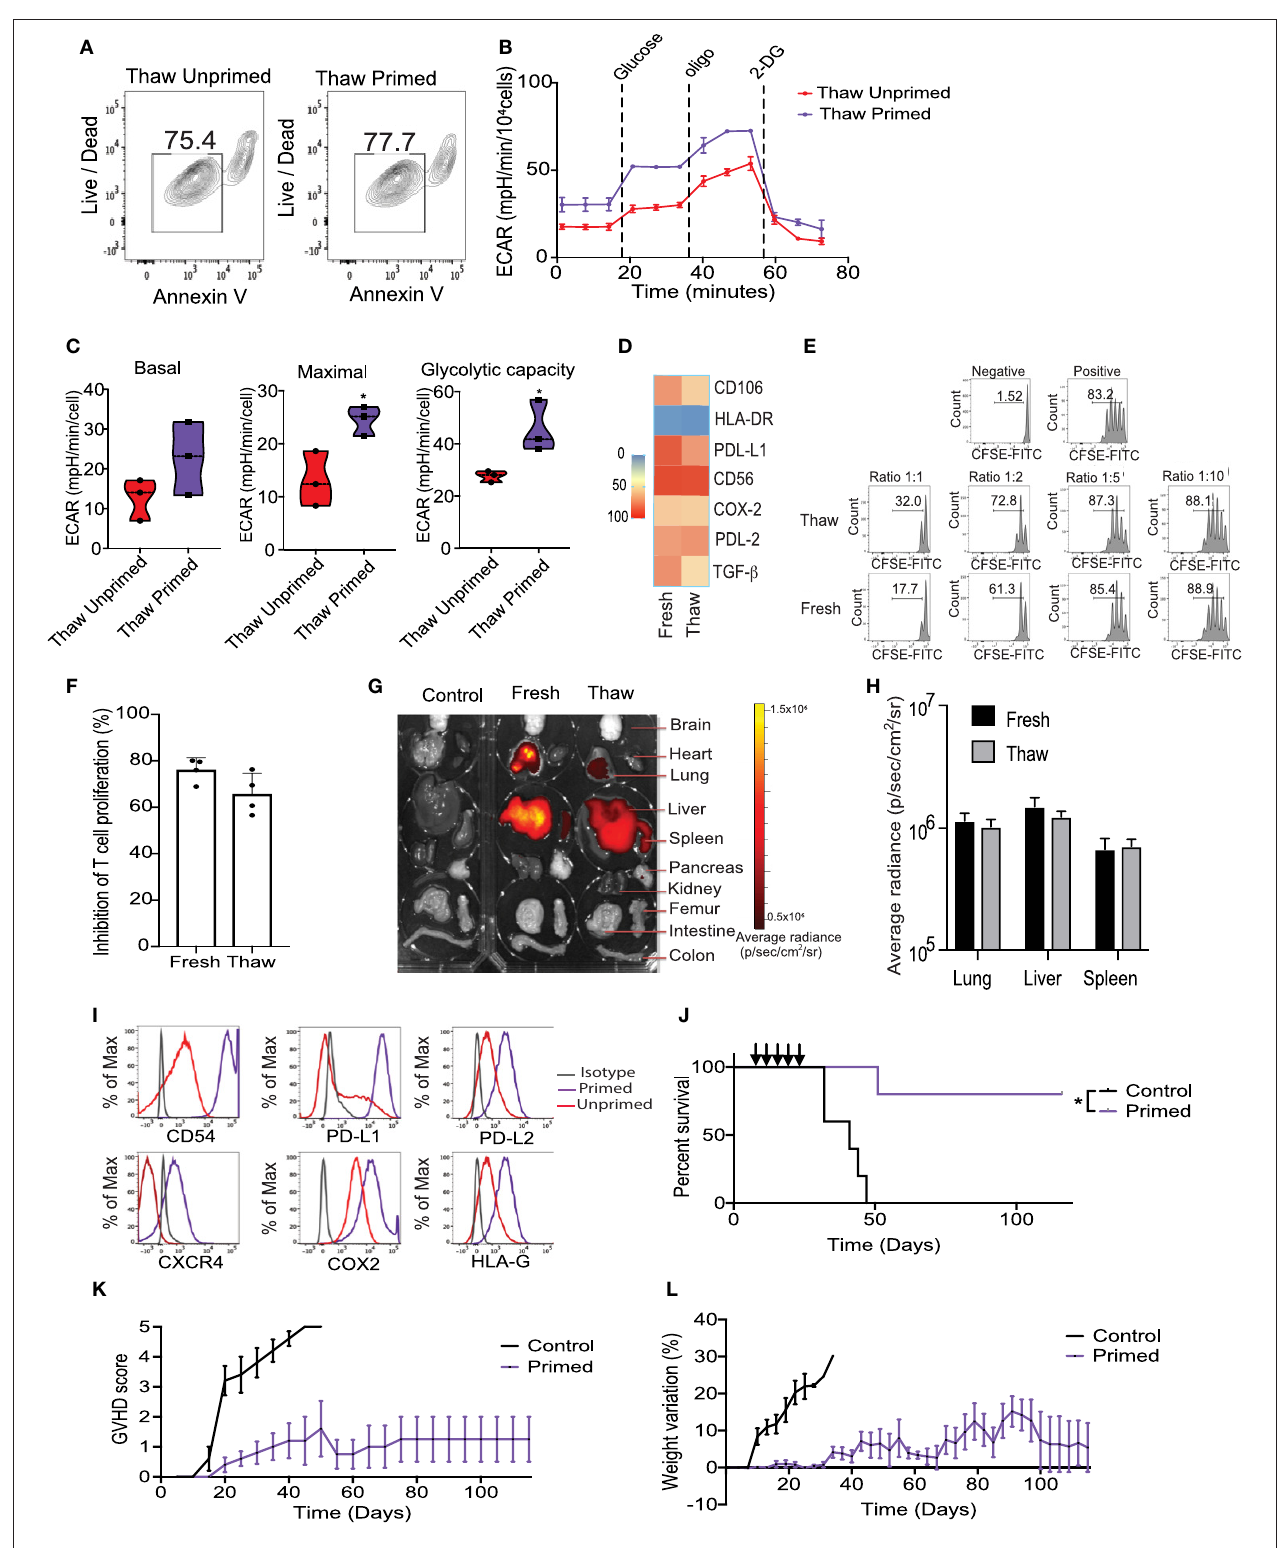
FIGURE 5 | Cryopreservation of MSC did not significantly impair the metabolic switch and immunosuppressive potential induced by the priming. (A) Representative contour plots showing the viability of thawed unprimed and primed MSCs ( n = 3). (B) Representative ECAR comparing thawed unprimed MSCs vs. primed